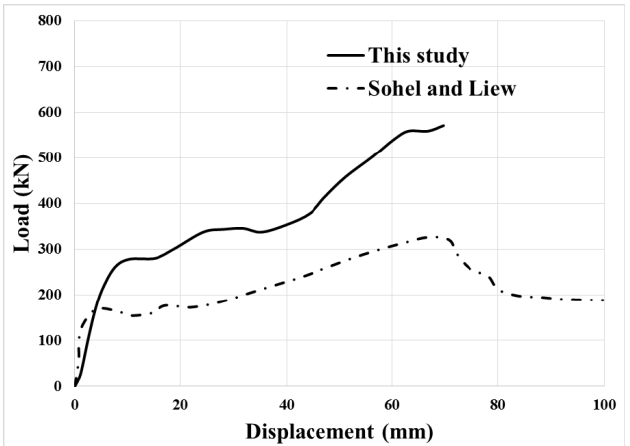
Figure 17. The comparison of the load-displacement curve of SCS slabs with J- hook and CSC connectors with SLWC core.